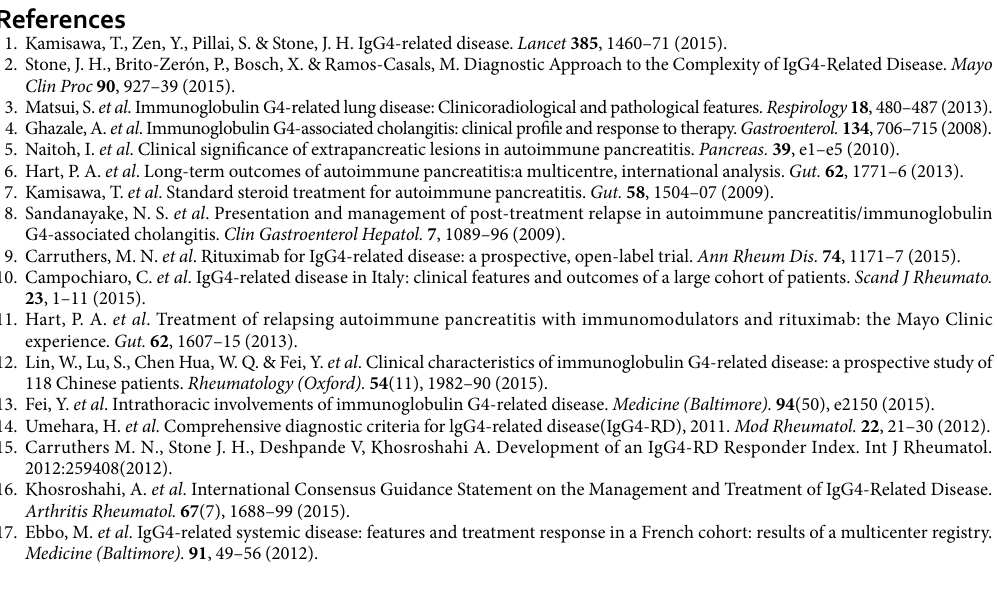
patients had significantly higher IgG4 levels than non-relapsing patients at baseline. As a consequence, it was clear that combined treatment of CYC decreased organs recurrence greatly and maintained disease remission. The patients with more than 6 organs involved should accept treatment of glucocorticoids and immunosuppressant agents at the beginning to prevent relapse. Besides, serum IgG4 level should be considered as a useful tool for therapy purpose. All the relapsing IgG4-RD patients in Group 1 accepted immunosuppressant agents therapy after disease flare, achieving CR or PR for a long time; only 1 relapsing IgG4-RD patient developed to diffuse large B cell lym- phoma. No difference of the total response rate was found between 2 groups at 12 months. Hence, we concluded that immunosuppressant agents had a good effect on most of relapsing IgG4-RD patients accepting therapy of glucocorticoids alone at initial. Long term cyclophosphomide toxicity was observed in our patients. Patients were monitored for a median follow-up period of 24.45 ± 7.37 (15~36) months. After 1 year, CYC could be changed to other immunosuppres- sant agents, including methotrexate, leflunomide, azathioprine, mycophenolate mofetil etc. No long term toxicity such as bladder cancer was reported. Our study also has some limitations, due to its non-randomized trait, leaving room for potential bias, but it worked almost as well as a matched study because the baseline characteristics showed no statistical differences between the 2 groups. The other concerning aspect is that the study is not blinded to doctors, which might affect disease activity and relapse assessment. In conclusion, glucocorticoids monotherapy is an efficient treatment for IgG4-RD patients, having almost the same effect as glucocorticoids and CYC at the initial stage, but glucocorticoids combined CYC treatment had better effect and lower relapse rate than glucocorticoids monotherapy overtime. The patients with more than 6 organs involved should receive glucocorticoids and immunosuppressant agents treatment at the onset. Immunosuppressant agents were efficacious for most relapsing patients treated with glucocorticoids alone.